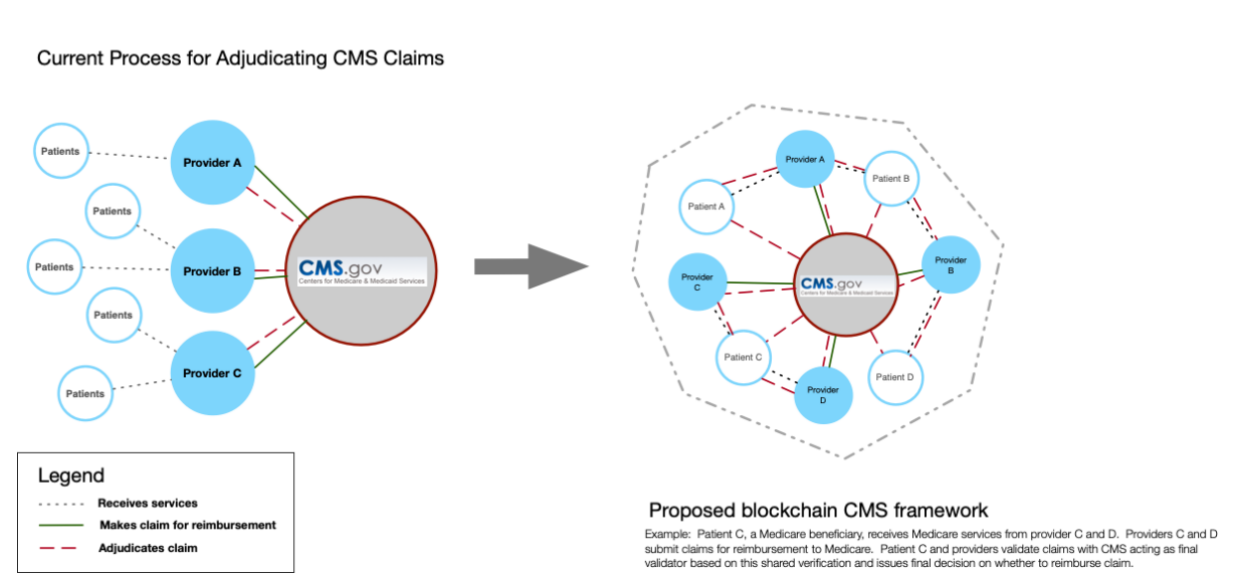
Figure 1. Visualization of the current process for Centers for Medicare and Medicaid Services claims reimbursement and proposed blockchain framework. CMS: Centers for Medicare and Medicaid